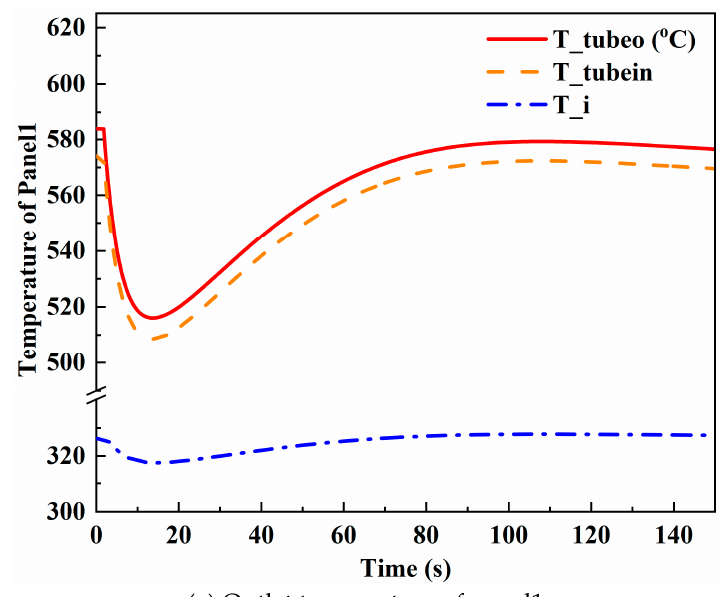
Table 3. Boundary conditions of each